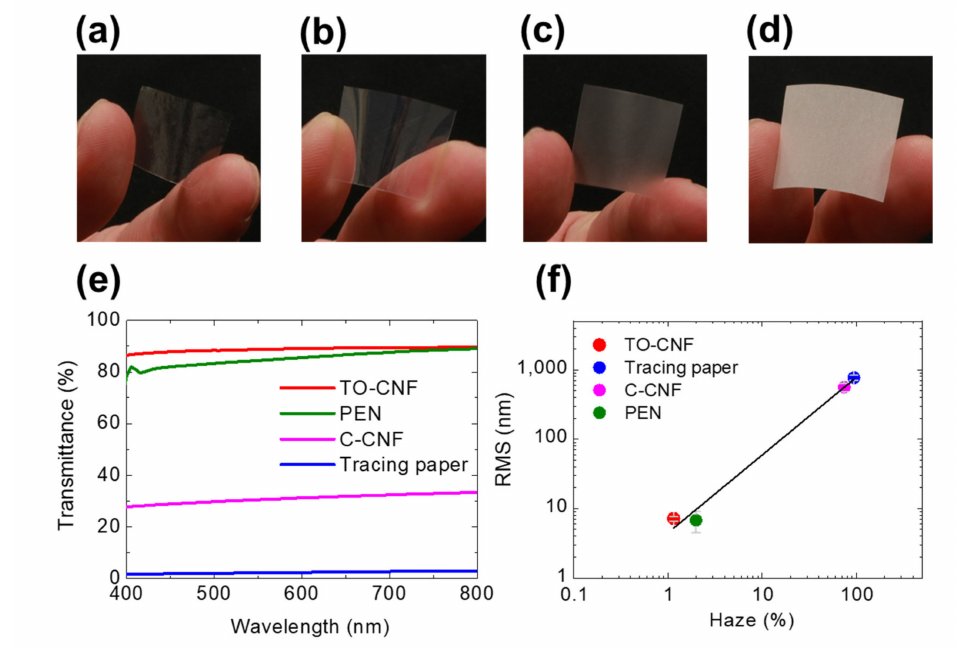
Figure 1. Photographs of ( a ) 2,2,6,6-tetramethylpiperidine-1-oxyl (TEMPO)-oxidized cellulose nanofiber (CNF) (TO-CNF), ( b ) polyethylene naphthalate (PEN), ( c ) commercial CNF (C-CNF), and ( d ) tracing paper films. ( e ) Transmittance spectra of each film. ( f ) The relationship between root mean square (RMS) roughness and